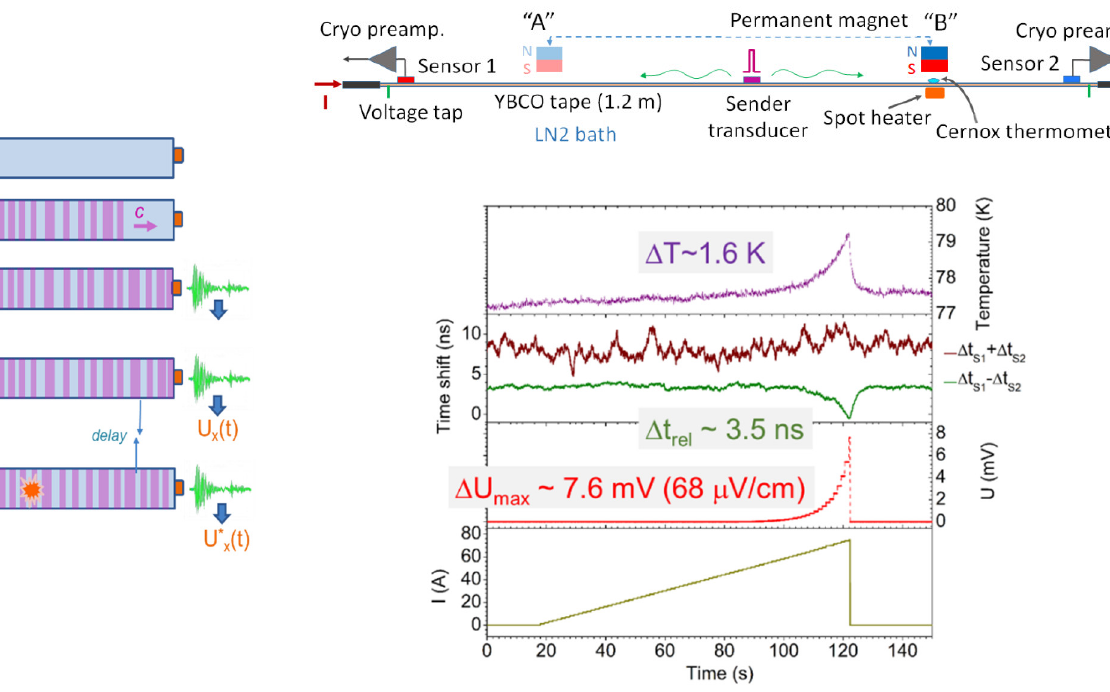
Figure 6. ( Left ) Principle of active acoustic thermometry: diffuse ultrasonic wave (coda) is being monitored for a time shift caused by local temperature variations in the interior of a monitored object. ( Right ) Demonstration of the active acoustic quench detection in a 1.2 m long ReBCO tape conductor in liquid nitrogen, where time shift associated with a hot spot formation is clearly detected along with the resistive voltage (adopted from [83]).